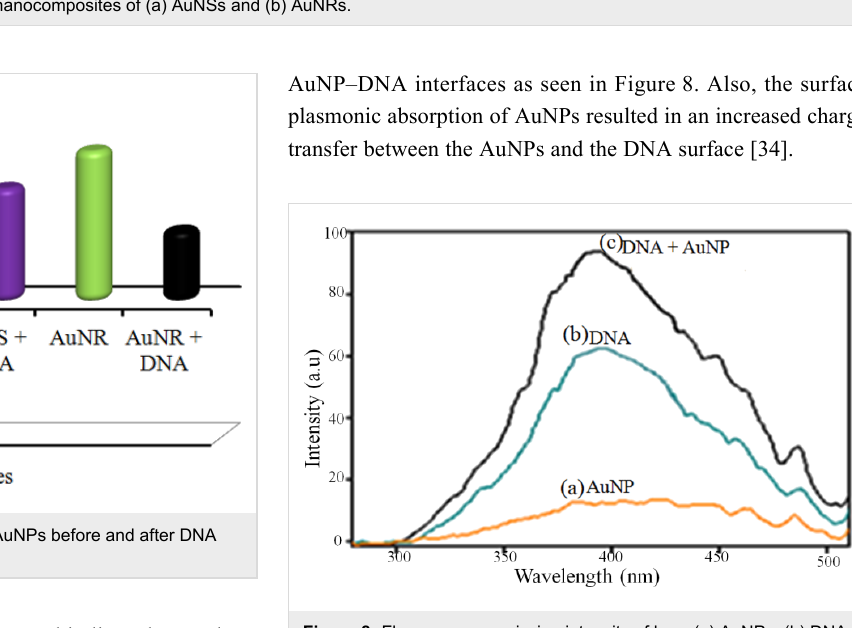
The Au–DNA NC material was used as a system to detect the presence of metal ions in a solution. Calcium (Ca), iron (Fe) and magnesium (Mg) were chosen because of their high abun- dance and importance in